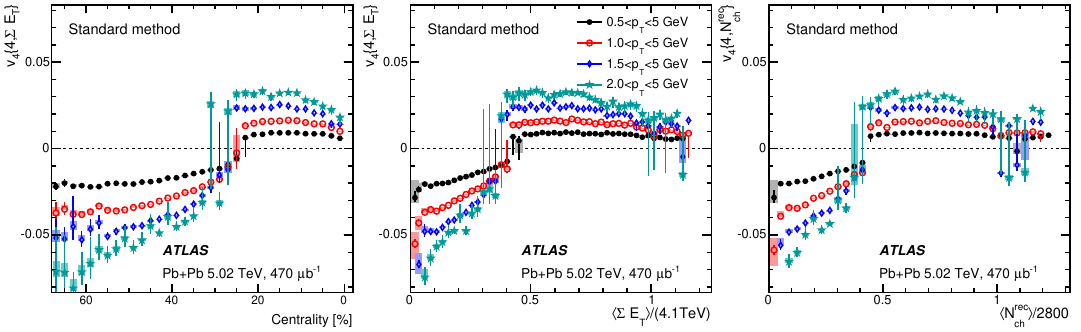
Figure 23 . The v 4 f 4 g values calculated for charged particles in four p T ranges as a function of centrality (left panel), (cid:6) E T (middle panel), and N rec boxes represent the statistical and systematic uncertainties, respectively. Zero is indicated by a dotted